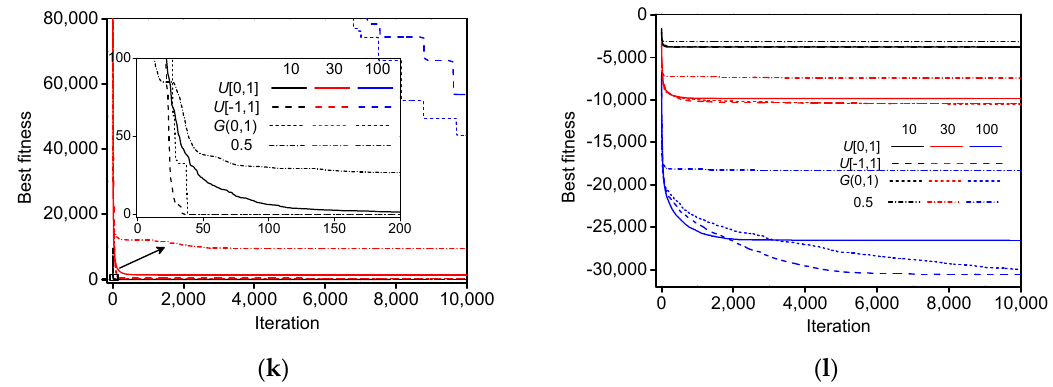
Figure 6. The mean best fitness of LDIW-PSO algorithm with different types of random values for benchmark functions: ( a ) Sphere1; ( b ) Sphere2; ( c ) Rastrigin; ( d ) Rosenbrock; ( e ) Griewank; ( f ) Ackley; ( g ) Levy and Montalvo 2; ( h ) Sinusoidal; ( i ) Rotated Expanded Scaffer; ( j ) Alpine; ( k ) Moved axis parallel hyper-ellipsoid; ( l ) Schwefel. (The solid, dash, short dash and short dash dot lines represent the random values generated by uniform distribution in the ranges of [0, 1] and [ − 1, 1], Gauss distribution, and 0.5, respectively; the black, red and blue lines represent the space dimensions 10, 30, and 100, respectively).